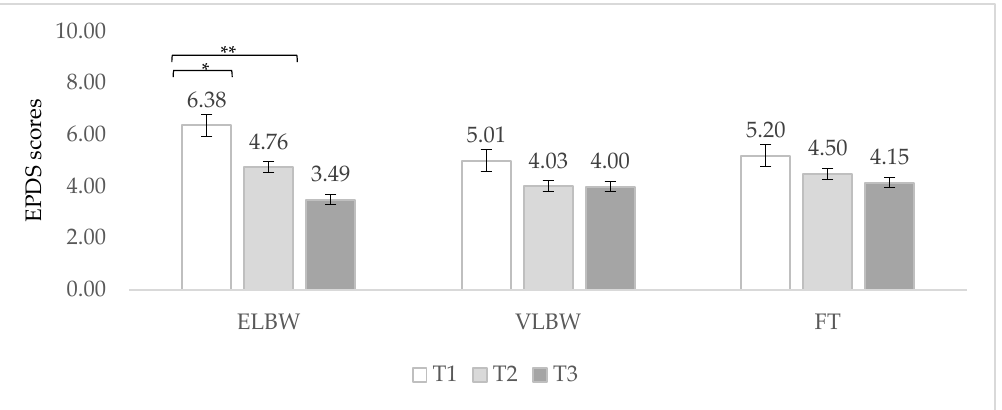
Figure 1. Fathers’ EPDS mean scores related to birth weight and time of assessment. Note . ELBW = extremely low birth weight; VLBW = very low birth weight; FT = full-term; T1 = 3 months; T2 = 9 months; T3 = 12 months. * p < 0.05. ** p < 0.005.